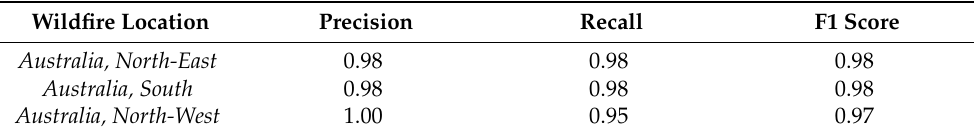
Table 8. In the three areas indicated, the precision, recall, and F1 scores were calculated. The dataset from north-east Australia was utilised for training, while the others were used for testing. Wildfire Location Recall